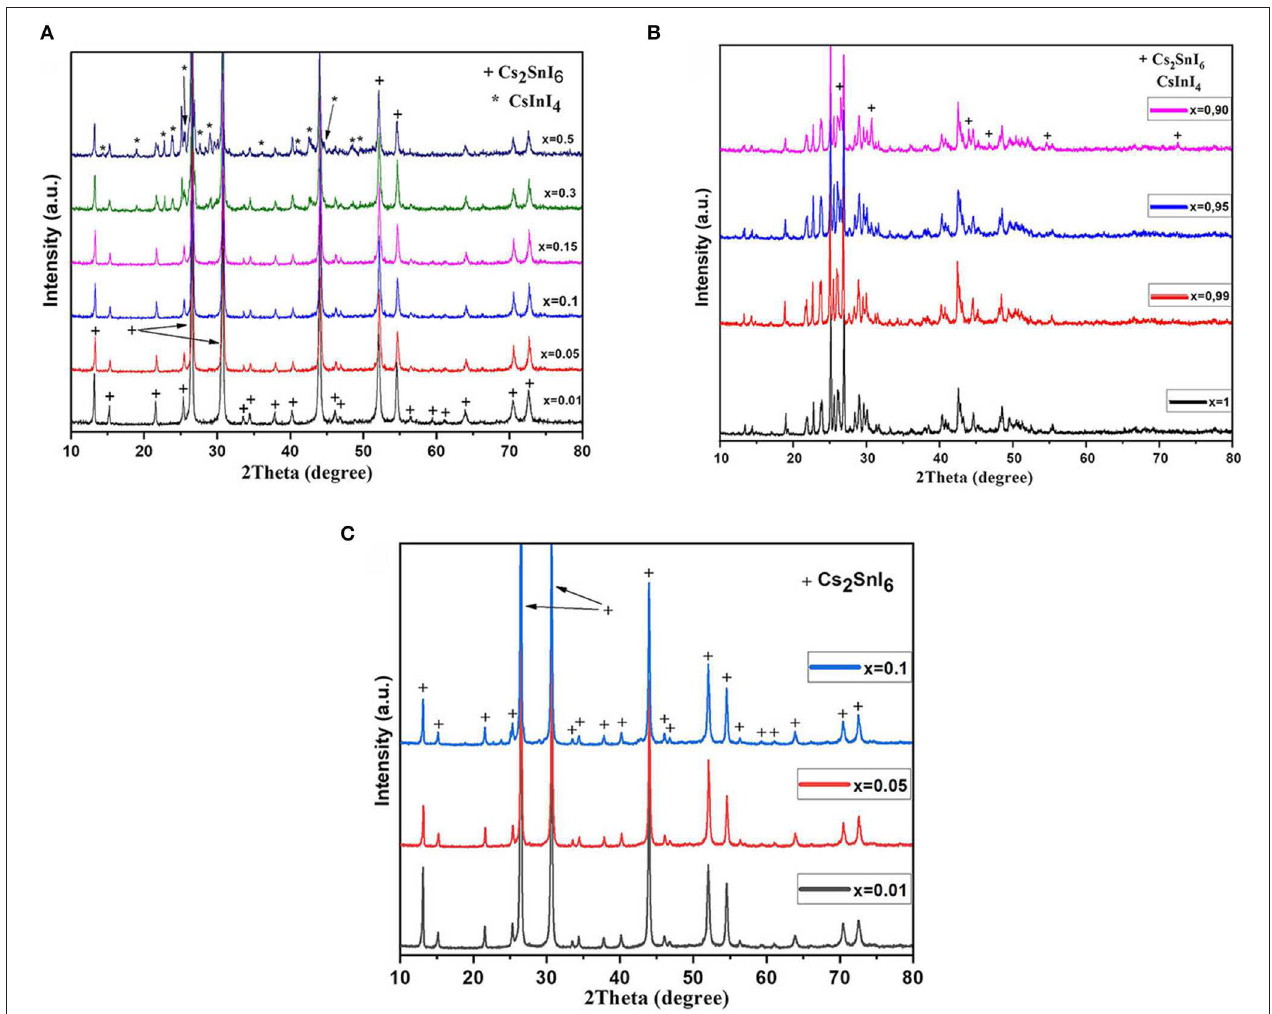
FIGURE 1 | (A) Powder XRD data for Cs 2 − x Sn 1 − x In x I 6 − 2 x ( x = 0.01–0.1) compounds. (B) XRD data of Cs 2 − x Sn 1 − x In x I 6 − 2 x with high substitution rate x ( x = 0.9 – 1). All unmarked reflections belong to the CsInI 4 phase. (C) XRD data of three samples with x = 0.01, 0.05, 0.1 ratio after a year of storage in air. “ + ” denotes Cs 2 SnI 6 reflections, and “*” indicates reflections of CsInI 4